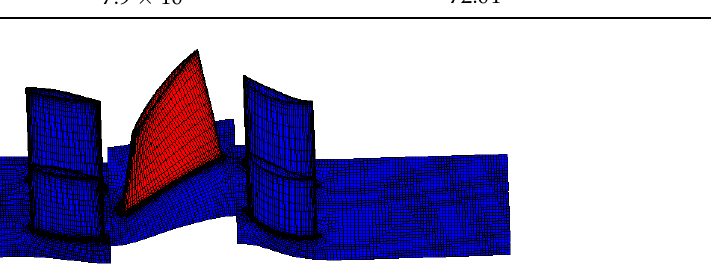
Figure 4. Mesh of rotor and stationary blades.